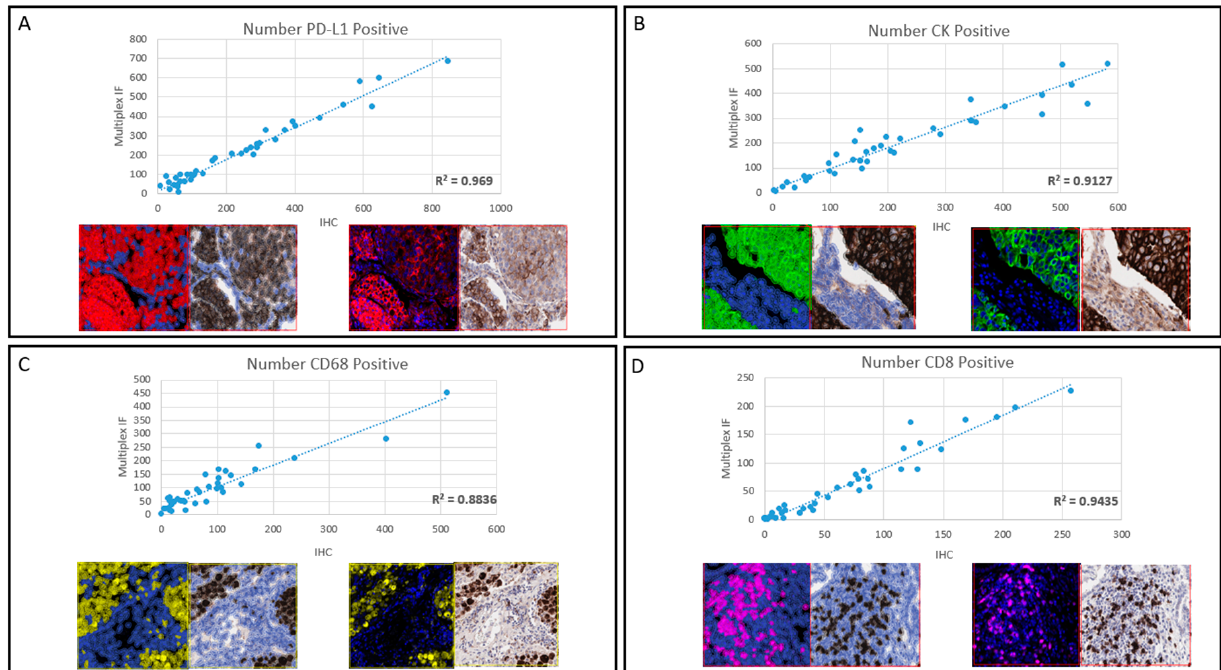
Figure 2. Biomarker concordance between the DAB IHC and the singleplex Opal fluorescence. Each panel displays a graph showing the single marker IF on the y -axis and the DAB IHC and the x -axis, for the number of cells detected. The image analysis mask overlaid on the mIF and IHC images are shown on the bottom left, with the native mIF and IHC image shown on the bottom right. Panel ( A ): PD-L1. Panel ( B ): CK. Panel ( C ) CD68. Panel ( D ): CD8. R 2 are displayed in the graphs. Images are ×20 magnification.